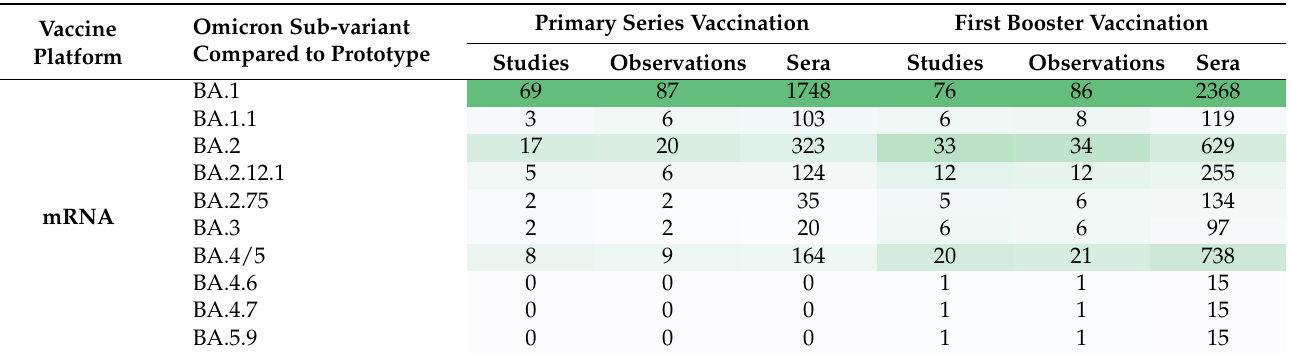
Table 1. Studies comparing Omicron sub-variants to prototype strain, availability of evidence per vaccine platform and Omicron